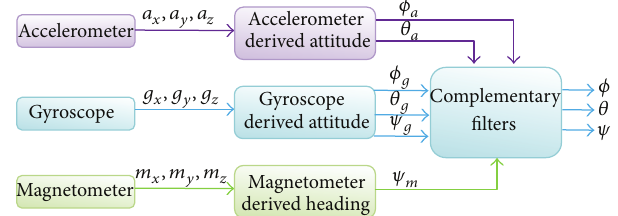
Figure 1: Block diagram of the fusion algorithm for AHRS.